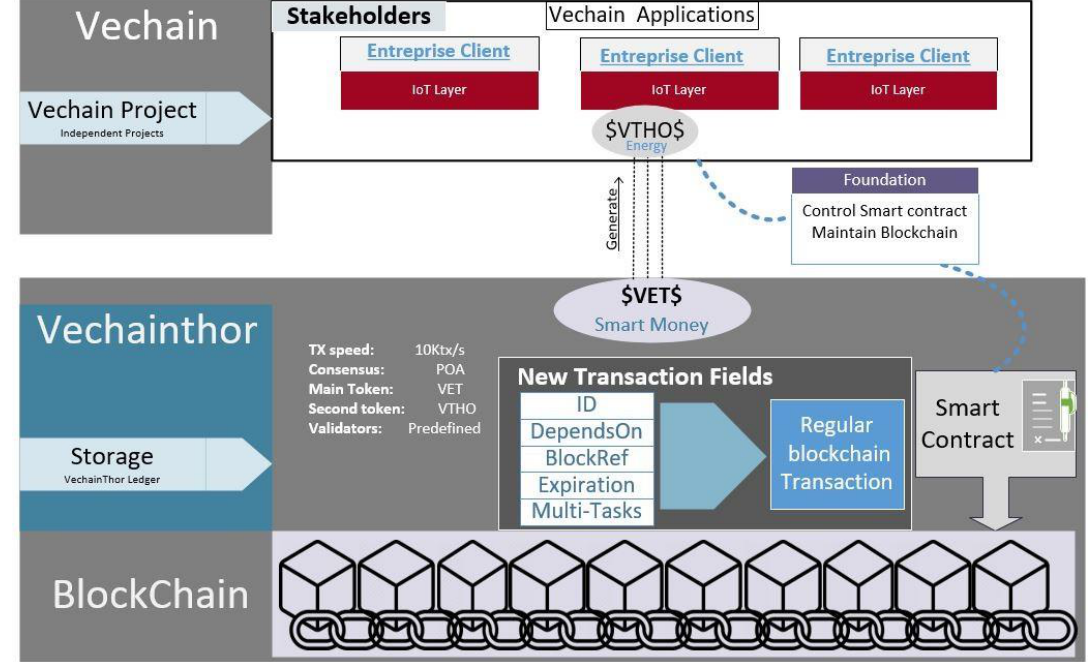
Figure 4. Vechain